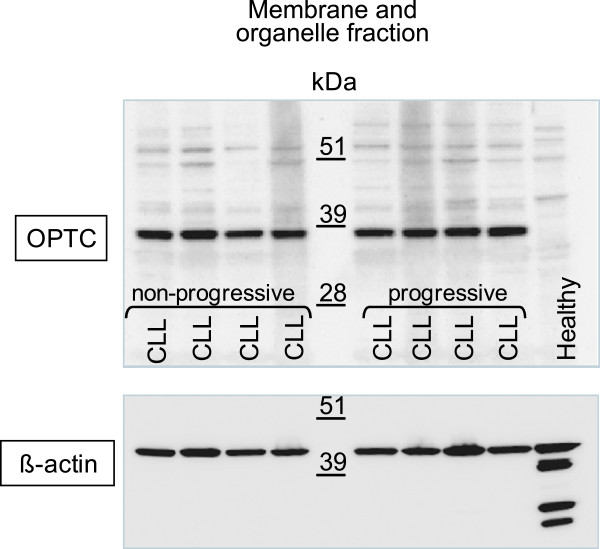
Western blot of cell lysates from CLL patients and healhty control donors. The membrane/organelle fraction from non-progressive (n = 4) and progressive (n = 4) CLL patients and from one healthy control. Upper panel: a rabbit anti- C-terminal OPTC pAb detecting a 37 kDa band in the membrane/organelle fraction of CLL cells but not in healthy donor PBMC. Lower panel: The same membrane stripped and re-probed with an anti-β-actin mAb. Multiple bands were detected in the healthy control while in CLL patients a single 42 kDa band was noted.